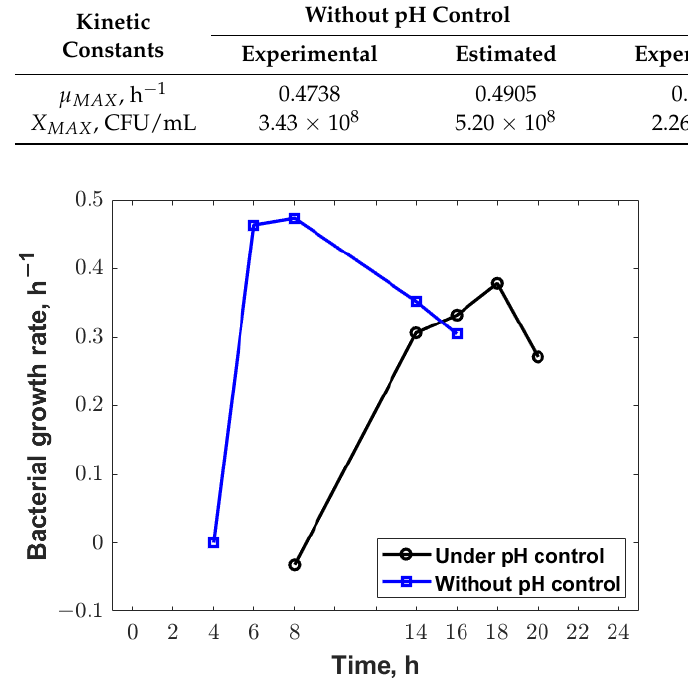
Table 2. Kinetic constants of the Verhulst (or logistic) model.